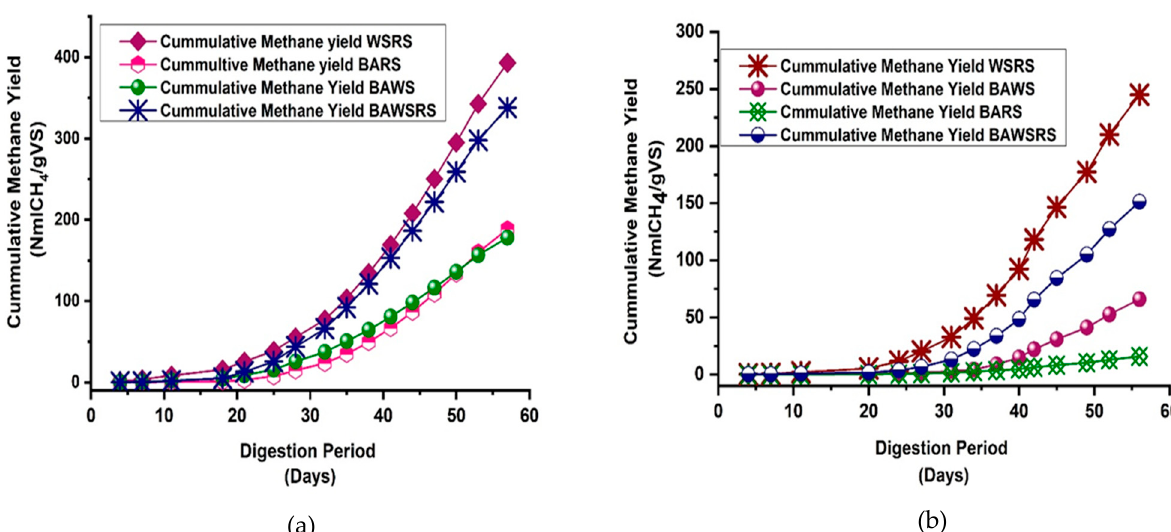
Figure 3. Cumulative Methane Yield (NmLCH 4 /gVS) of S/I ratio, ( a ) 1.5 and ( b ) 2.5 . Table 2. pH and VS Reduction % after Co-digestion of S/I Ratio 1.5.